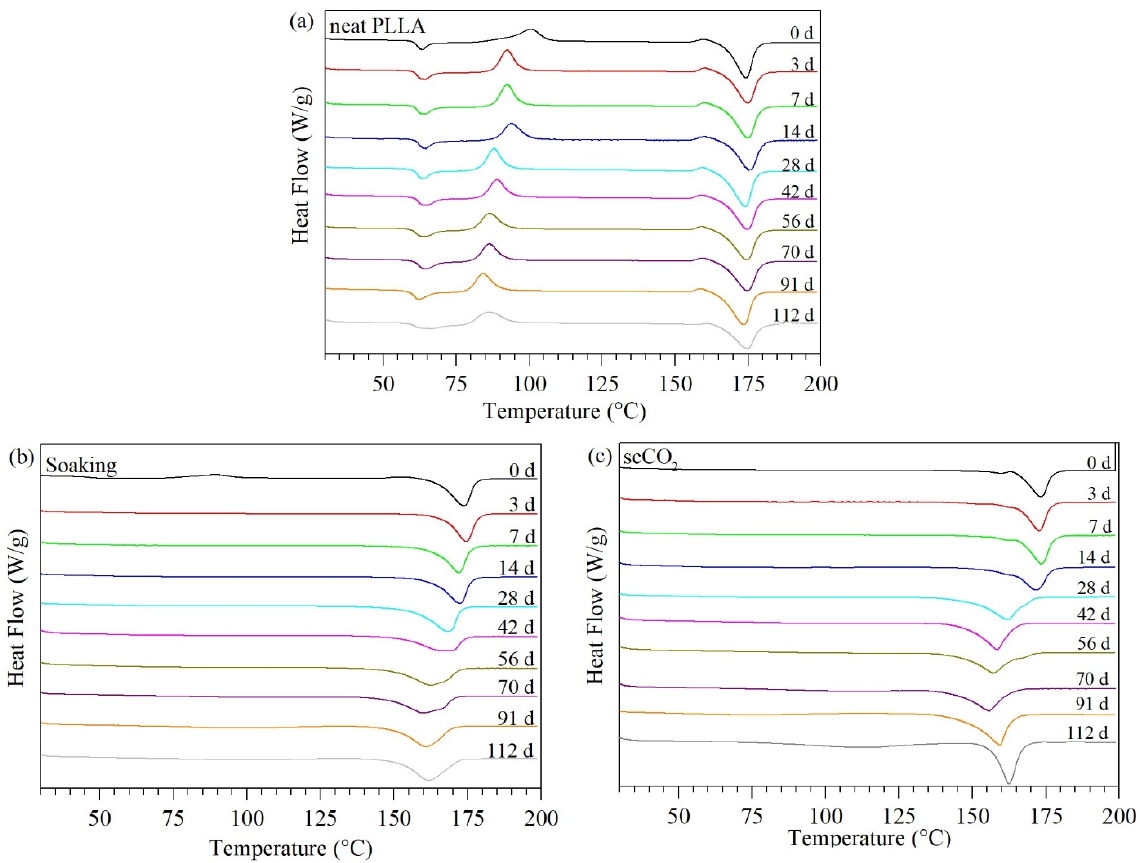
Figure 8. First heating DSC thermograms of PLLA during the degradation study at 37 °C in PBS of ( a ) neat PLLA, ( b ) PLLA impregnated using the soaking method, and ( c ) PLLA impregnated using scCO 2 impregnation method.